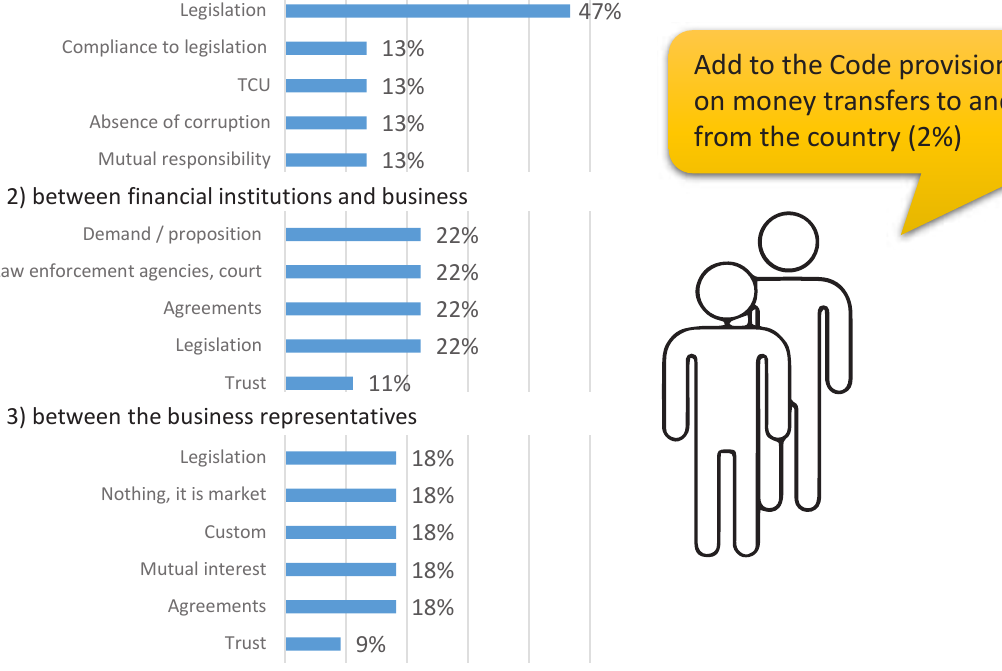
Figure 7. Structural indicators of answers to questions that determine the optimistic and pessimistic expectations and alternatives of the respondents,